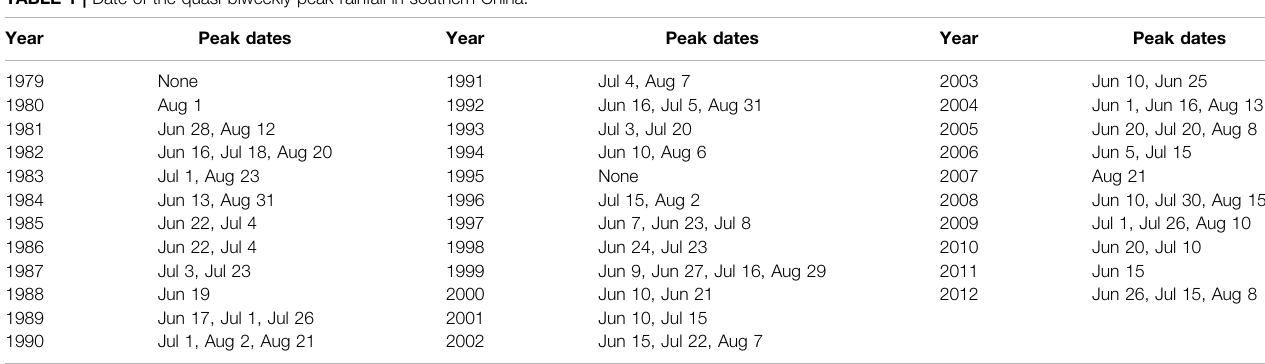
TABLE 1 | Date of the quasi-biweekly peak rainfall in southern